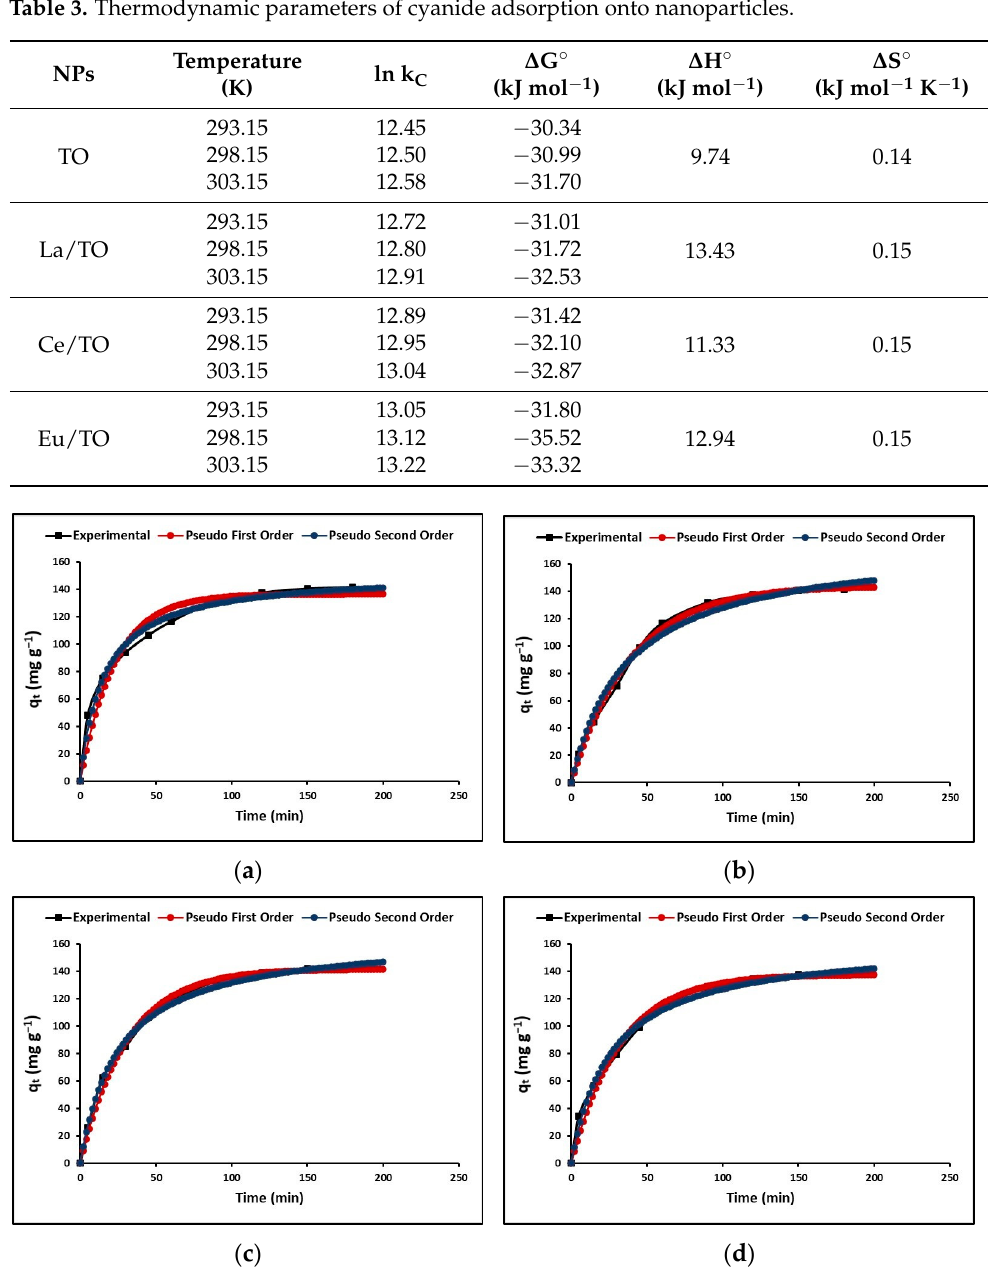
Figure 9. Adsorption kinetics of ( a ) TO, ( b ) La/TO, ( c ) Ce/TO, and ( d ) Eu/TO.